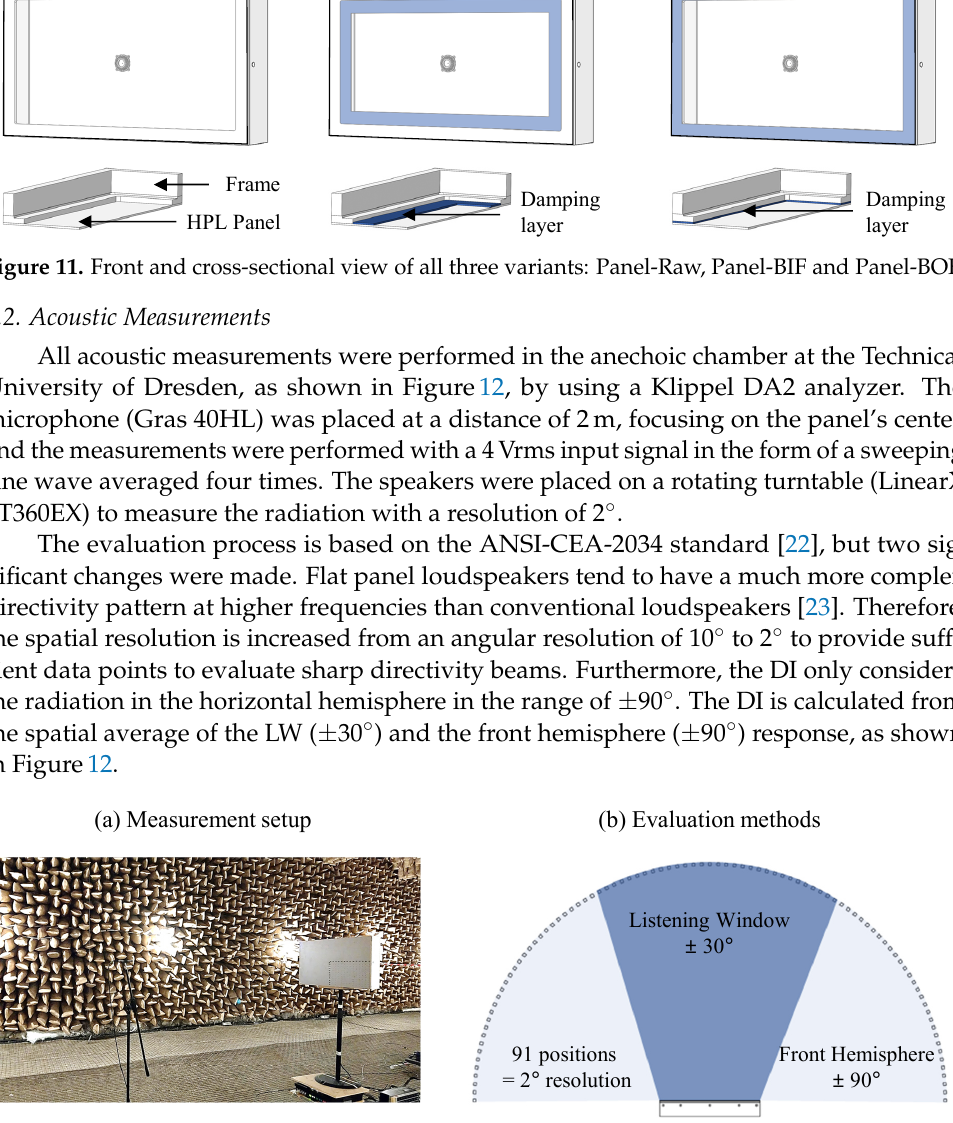
Figure 12. ( a ) Measurement in the anechoic chamber at the Technical University of Dresden; and ( b ) evaluation of the sound radiation by calculating the LW and FH